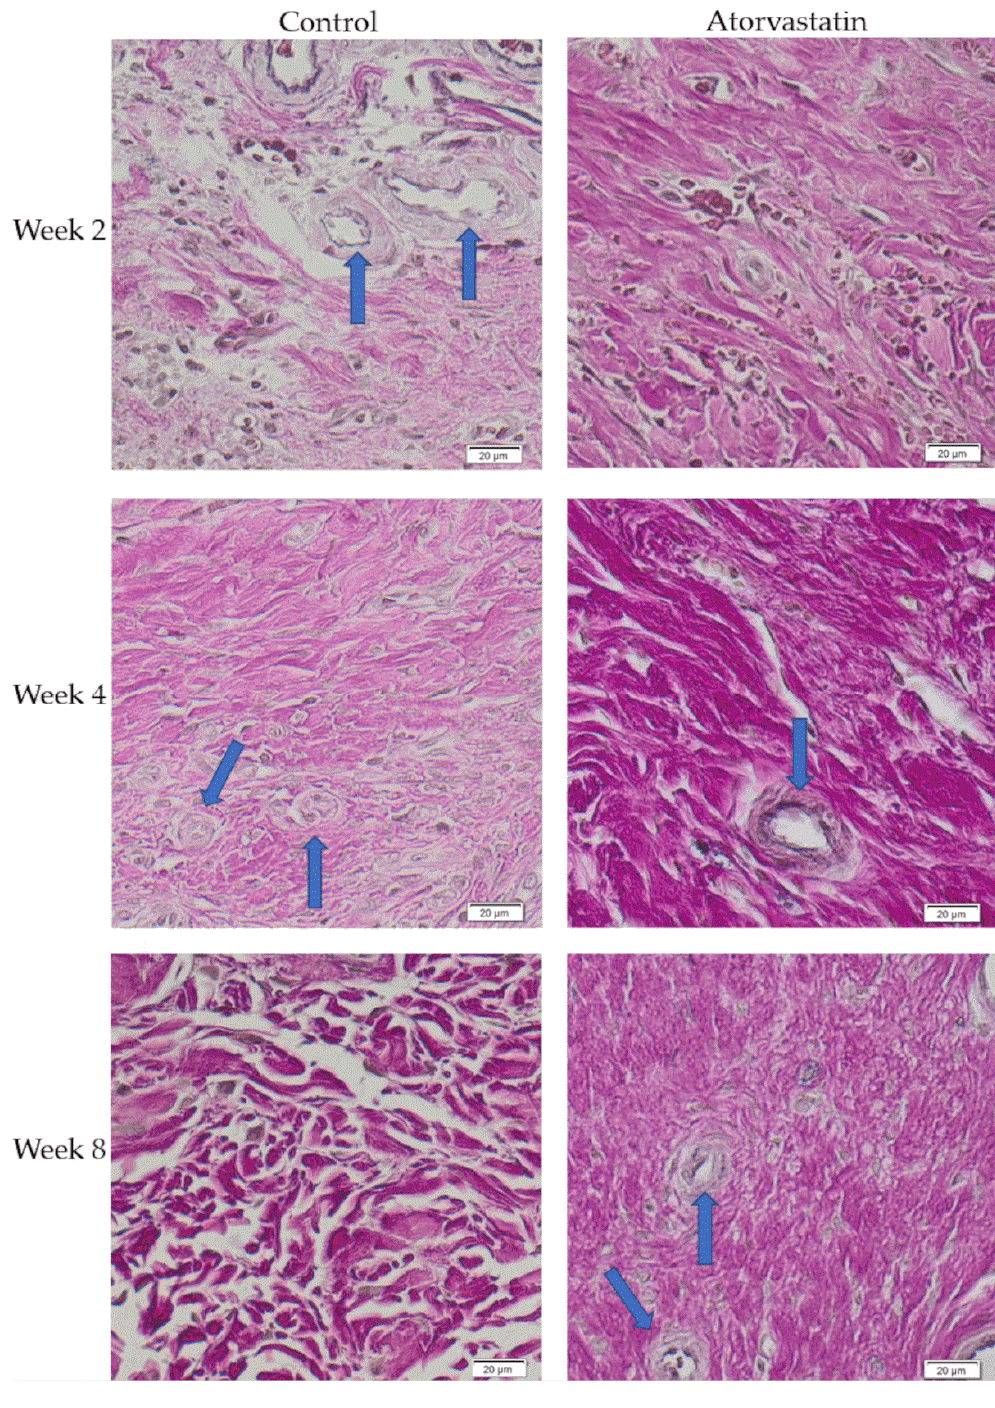
Figure 8. Elastica van Gieson staining of the posterior joint capsule. Collagen is shown in pink, and blood vessels are shown with a blue arrow. blood vessels are shown with a blue